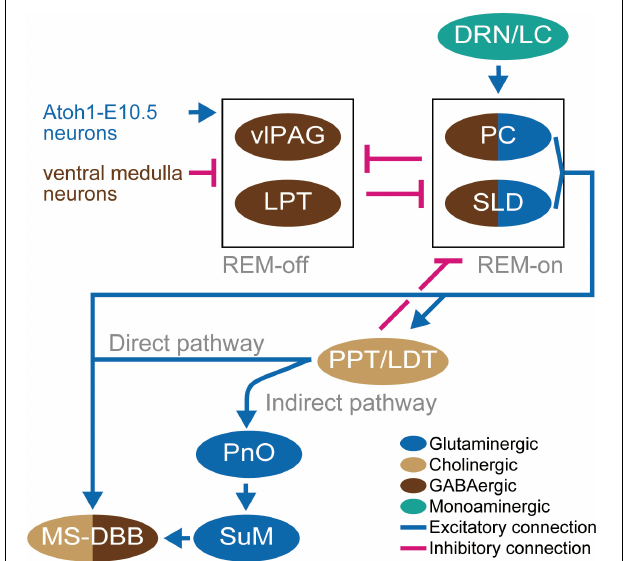
FIGURE 3 | Schematic diagram of the neural circuit for EEG theta oscillation. Light brown ellipsoids represent cholinergic neurons, blue ellipsoids represent glutaminergic neurons, dark brown ellipsoids represent GABAergic neurons, and green ellipsoid represents monoaminergic neurons. Blue connections and red connections represent excitatory and inhibitory connections, respectively. Blue and dark brown letters for neurons represent glutamatergic and GABAergic neurons, respectively. The neurons represented by only letters are not depicted in ellipsoid because the definition of their residing brain regions has not been established